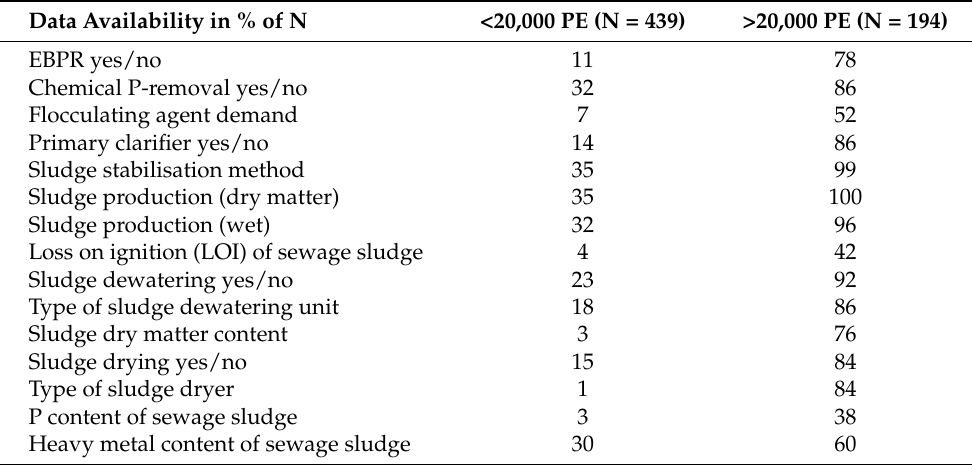
Table 1. Recovered data and data availability after data curation for wastewater treatment plants (WWTPs) bigger than 20,000 and smaller than 20,000 PE.